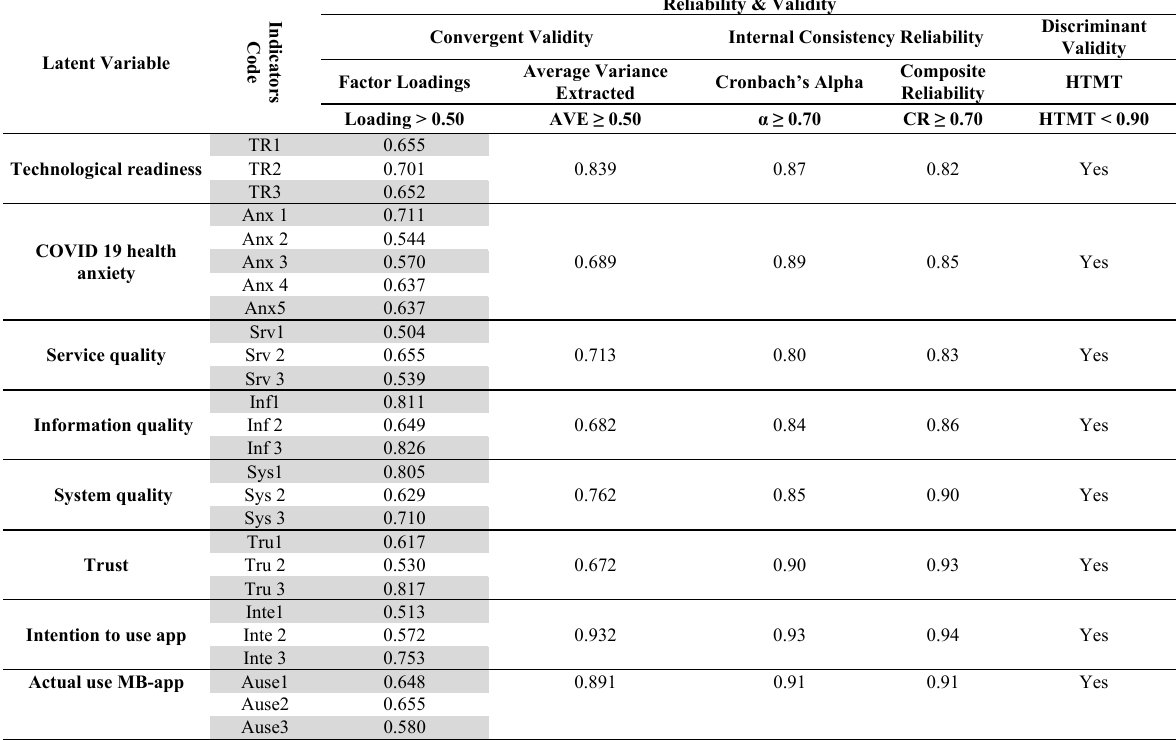
Factor Loading, Cronbach’s Alpha, CR, AVE and